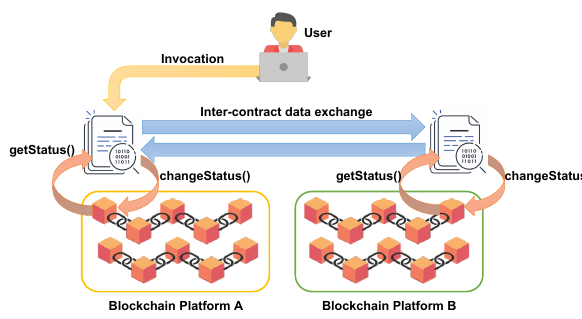
Figure 4. Inter-blockchain smart contract implementation